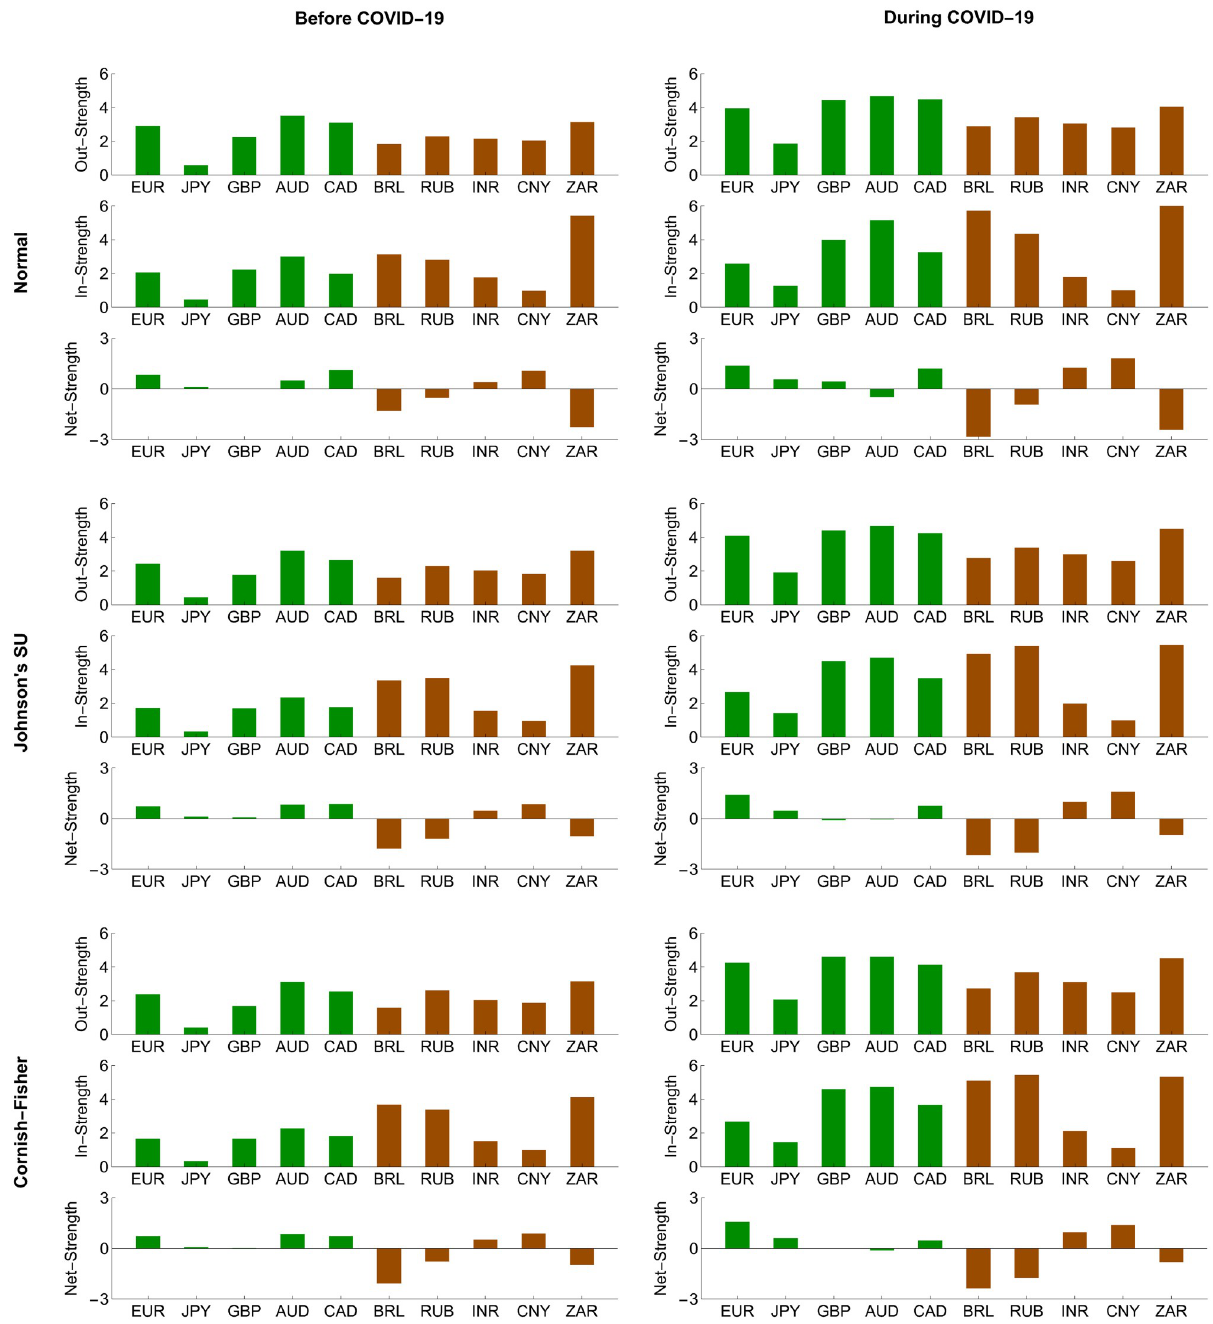
Fig 8. Node strength measures of conditional tail risk networks based on Δ CoVaR forecasts. Green and brown represent the advanced and emerging forex markets, respectively.